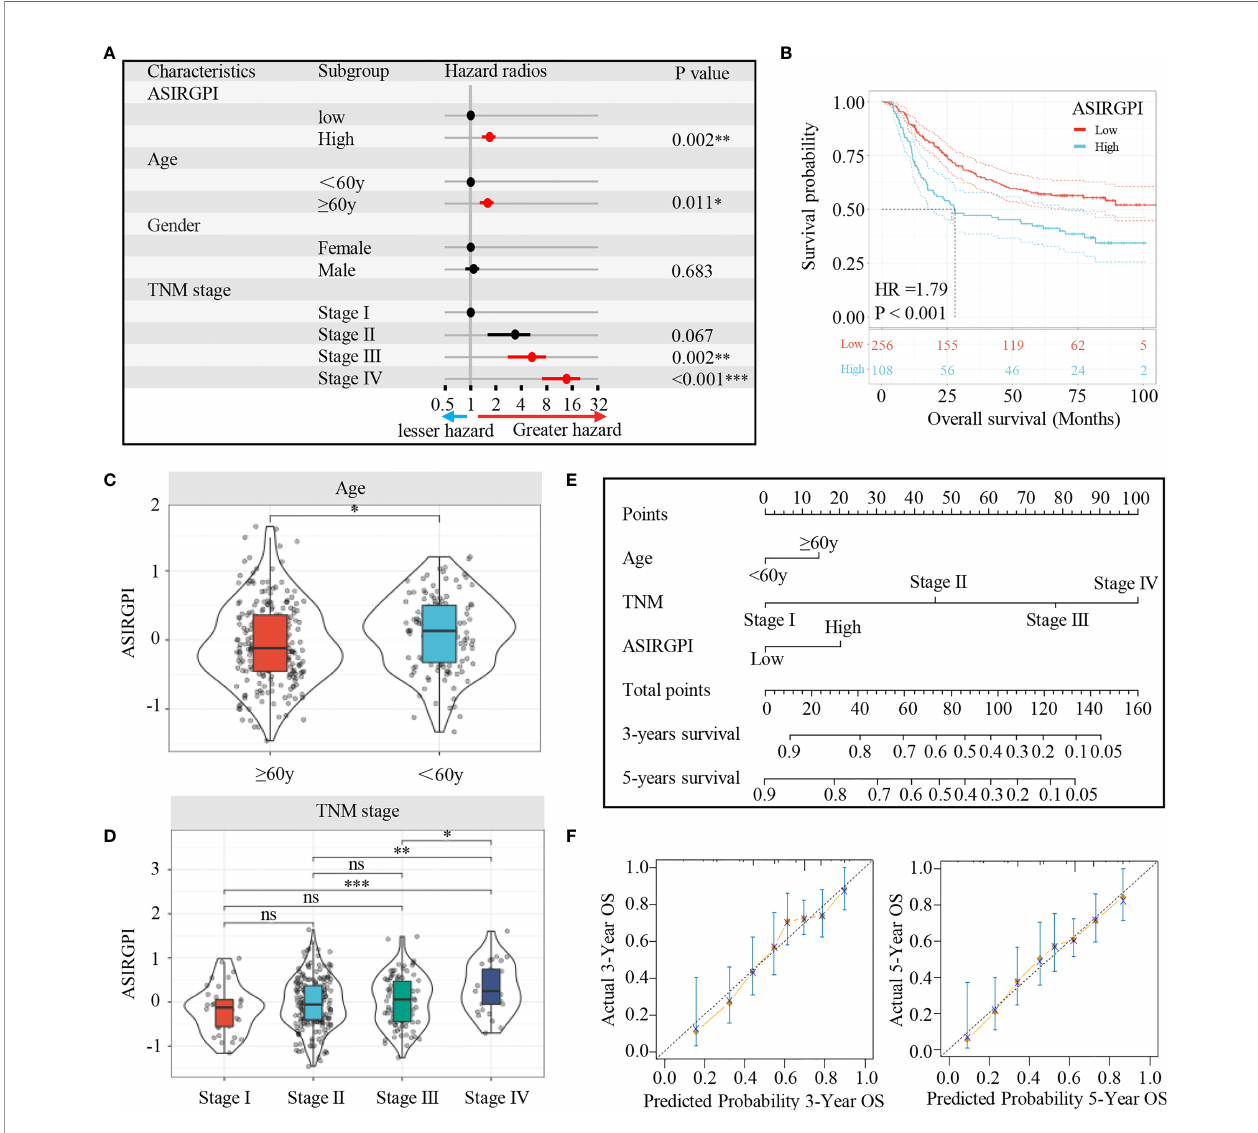
FIGURE 5 | (A) Multivariate Cox analysis evaluating independently predictive ability of the risk score and other clinical risk factors for OS. The square data markers indicate estimated hazard ratios. The error bars represent 95% CIs. (B) Kaplan – Meier curves for the high (n = 108) and low (n = 256) ASIRGPI patient groups in the Asian GCs. Log-rank test, P < 0.001. (C, D) The relationship between ASIRGPI with clinical and demographic characteristics. (E) Development of a nomogram based on the ASIRGPI to predict the 3-year and 5-year overall survival for AGC patients. (F) Calibration plot of the nomogram for predicting the probability of OS at 3, and 5 years in Entire cohort of 364 AGC patients. ns, no signi fi cance, *P < 0.05, **P < 0.01 and ***P <